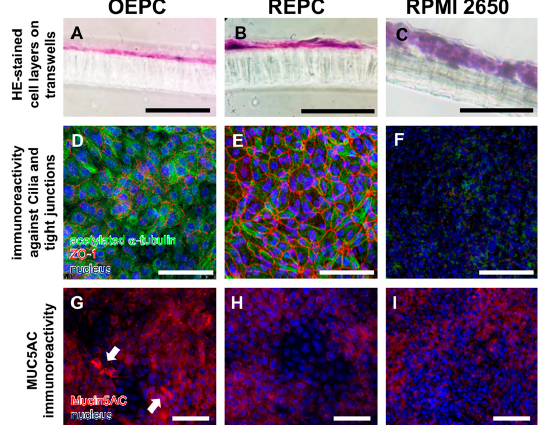
Figure 3. Characterisation of olfactory and respiratory primary cells in comparison to the standard cell line RPMI 2650. Monolayers are necessary to evaluate transport over the epithelial layer in the nasal mucosa: 14 µm sections were made of olfactory epithelium primary cells (OEPC, A ), respiratory epithelial primary cells (REPC, B ) and RPMI 2650 ( C ) grown on a cell insert membrane for 21 days. Morphological features such as tight junctions and the formation of cilia are important influencing factors in investigations of drug permeation and clearance studies. Acetylated α -tubulin is a common marker for cilia [54]. IF double-staining of acetylated α -tubulin and the tight junction marker zonula occludens-1 (ZO-1) of ALI cultures of OEPC ( D ), REPC ( E ) and RPMI 2650 ( F ) after 21 days of incubation were made. An additional feature of mucosal cells is the ability to produce mucus. The marker protein mucin 5AC was used in this work, because the olfactory mucosa is to be simulated above all to investigate nose-to-brain transport. Again, IF was performed in OEPC ( G ), REPC ( H ) and RPMI 2650 ( I ). Scale bars: 100 µm.